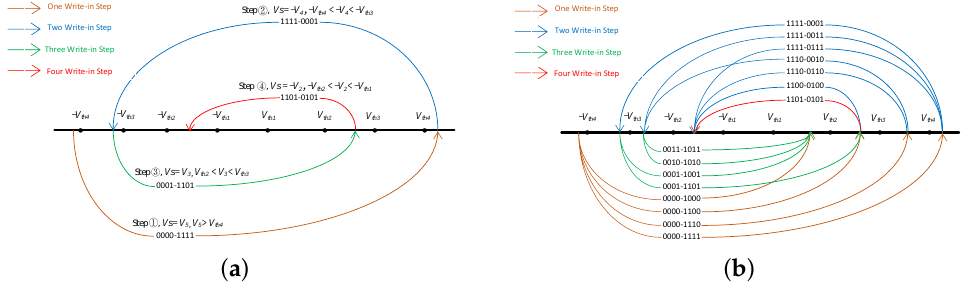
Figure 4. The step of writing data 1010 ( a ) and other steps of 16 kinds of 4-bit data ( b ).